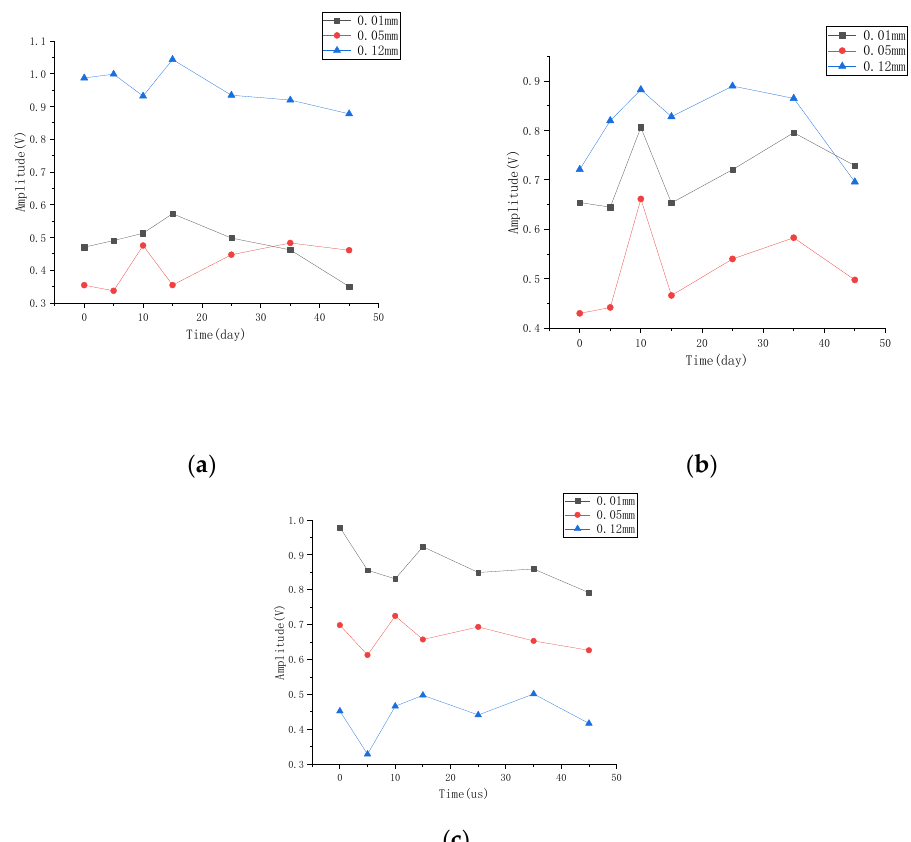
Figure 9. Variation of characteristic parameter amplitude with aging time. ( a ), ( b ), and ( c ) correspond to the change of amplitude with aging time for the AW106, E-30CL, and E-120H adhesives, respectively.